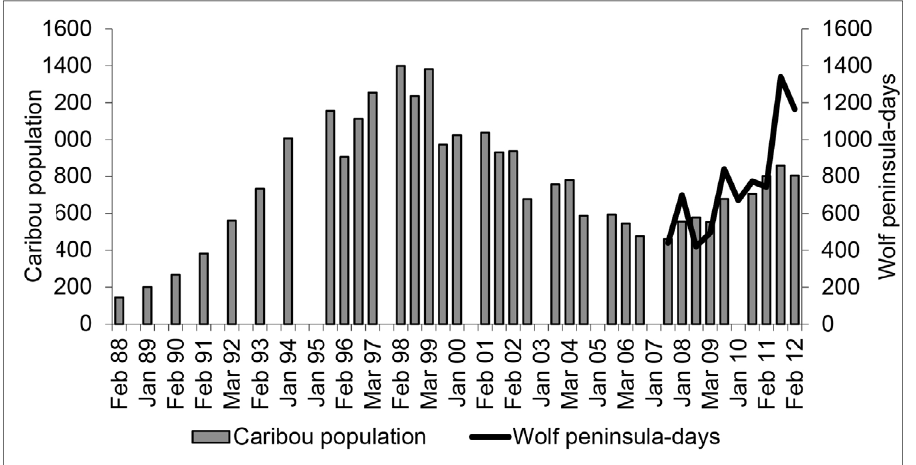
Figure 3. Nushagak Peninsula caribou herd population estimates, 1988-2012, and total estimated time spent by wolves on the Nushagak Peninsula, 2007-2012, Togiak National Wildlife Refuge, southwestern